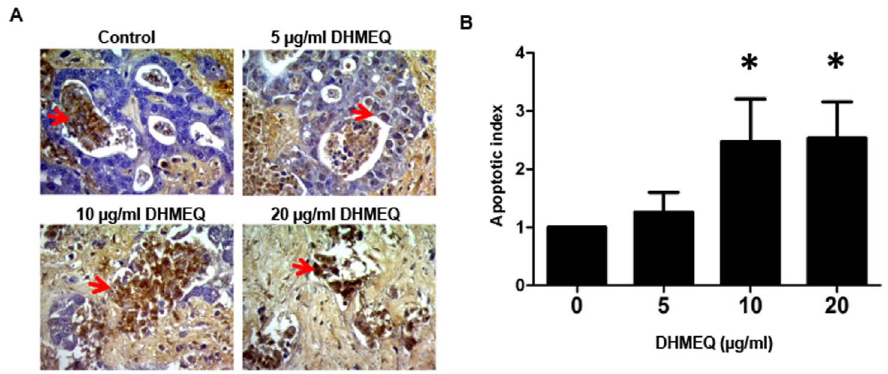
Figure 6. Inhibition of NF- k B action induced cell apoptosis in primary histoculture of CCA patient tissues. Tumor tissues of CCA patients (n = 4) were cultured in medium containing 20% fetal calf serum in the absence or presence of 5, 10 and 20 m g/mL DHMEQ for 4 days. A) Apoptotic cells in tumor tissues were determined using the TUNEL assay. B) The number of apoptotic cells observed in DHMEQ-treated tissues was increased significantly compared with those of the control. Red arrows indicated TUNEL-positive nuclei (dead cells) and the blue stained cells were TUNEL-negative nuclei (alive cells), magnification 6 40. * P , 0.05 independent-sample t-test compared to the control group.